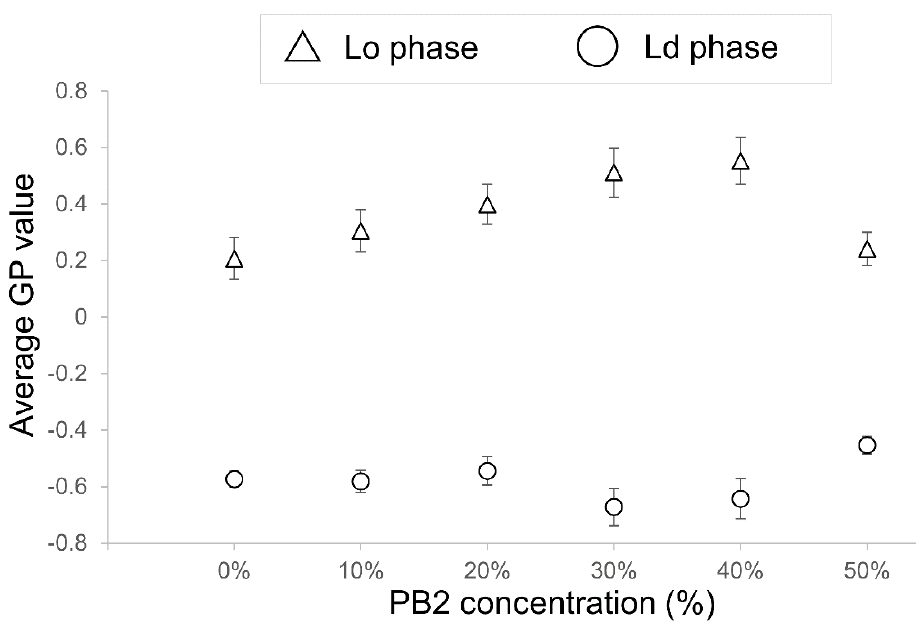
Figure 5. Average GP values of procyanidin b2-containing membranes (n = 15). High GP value means low fluidity of the membranes, whereas low GP values mean a high fluidic state in the membrane. Triangles represent GP values of liquid-ordered (Lo) phase membranes, and circles indicate GP values of liquid-disordered (Ld) phase membranes. The bar on each marker shows the standard error of the GP values for each component. Lipid compositions for the liposomes were DOPC/DPPC/Chol/PB2 40:40:20:0, 36:36:18:10, 32:32:16:20, 28:28:14:30, 24:24:12:40, and 20:20:10:50. Based on previous studies, DOPC/DPPC/20 40:40:20 liposomes were used as a control for Lo/Ld phase separation liposomes [12,25,26].